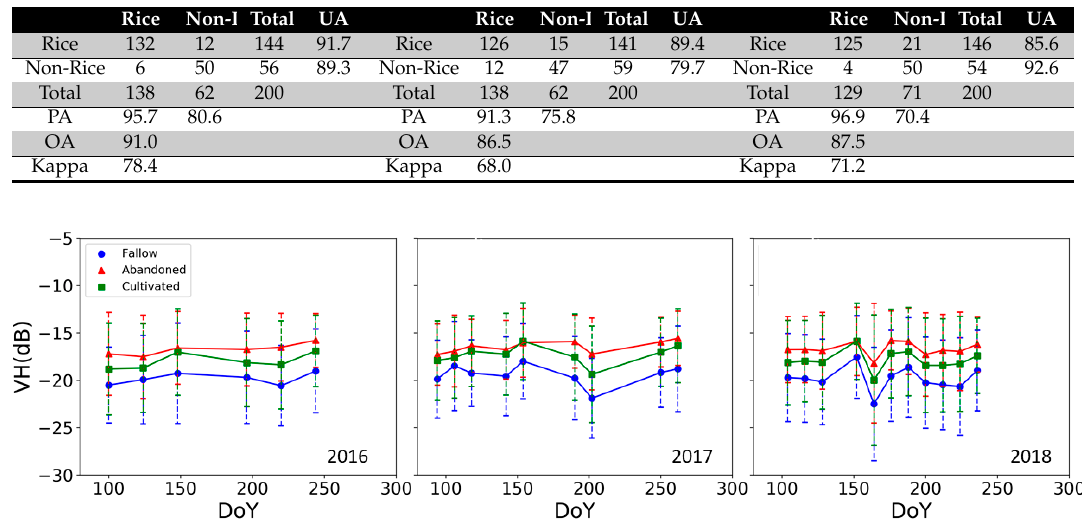
Table 1. Accuracy assessment for 2016, 2017, and 2018 using co-timed VHR optical imagery. OA: Overall accuracy; PA: Producer’s accuracy; UA: User’s accuracy.